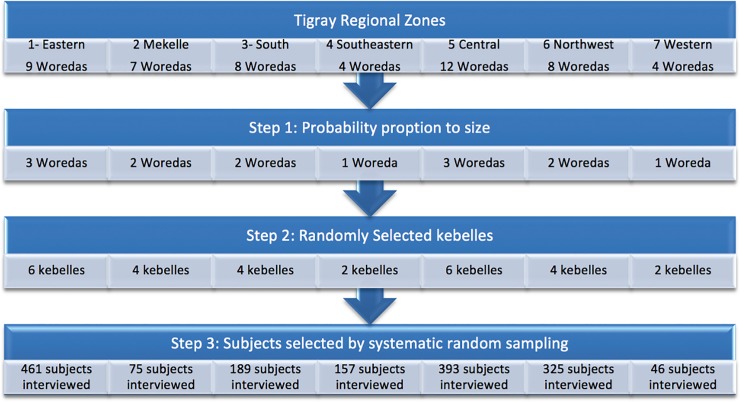
Schematic presentation of the samplicing procedure.Tigray Region is the northernmost of the nine regions of Ethiopia. There are seven administrative zones: comprising a total of 47 Woredas (districts) and 673 Kebelles (neighborhoods).